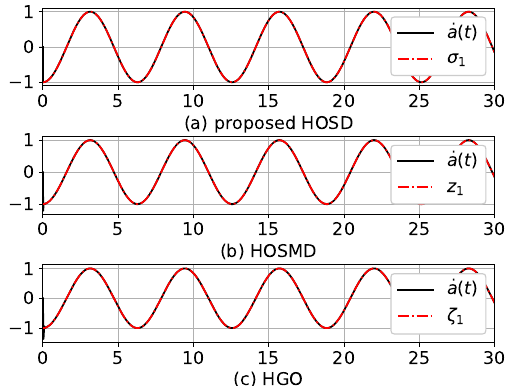
Figure 6. Estimations of ˙ a using parameter set 3 (cid:13) in Table 1.